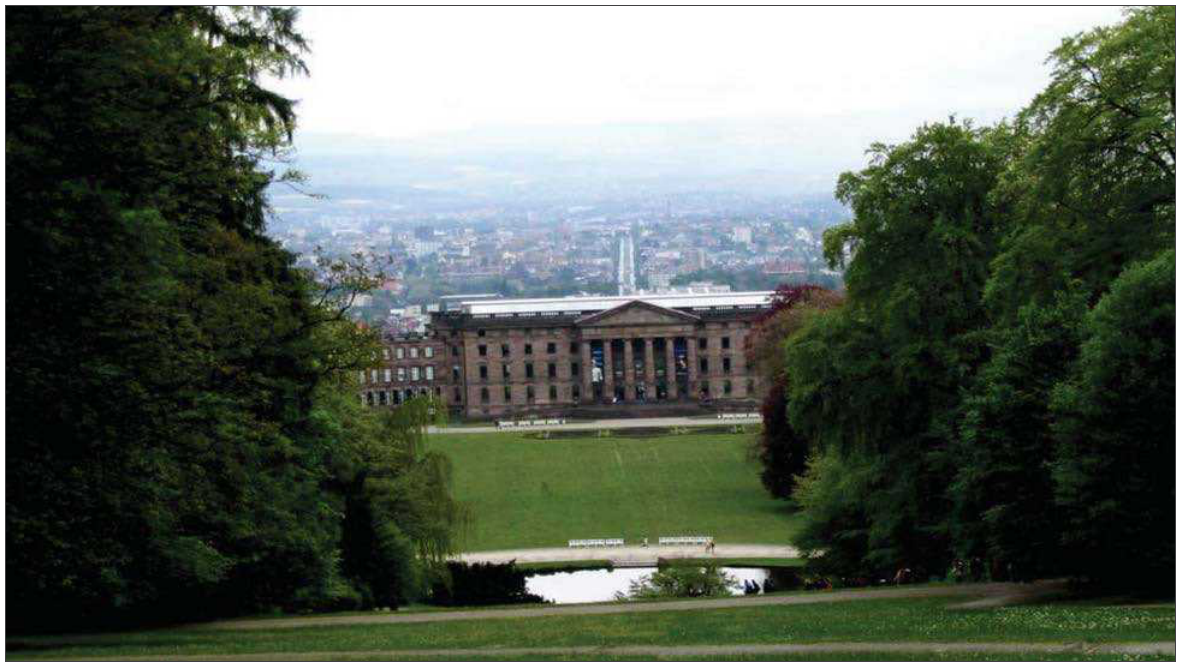
Fig 2. Former manor site as public space with townscape view. Cassel (Germany) (author‘s photo, 2005)